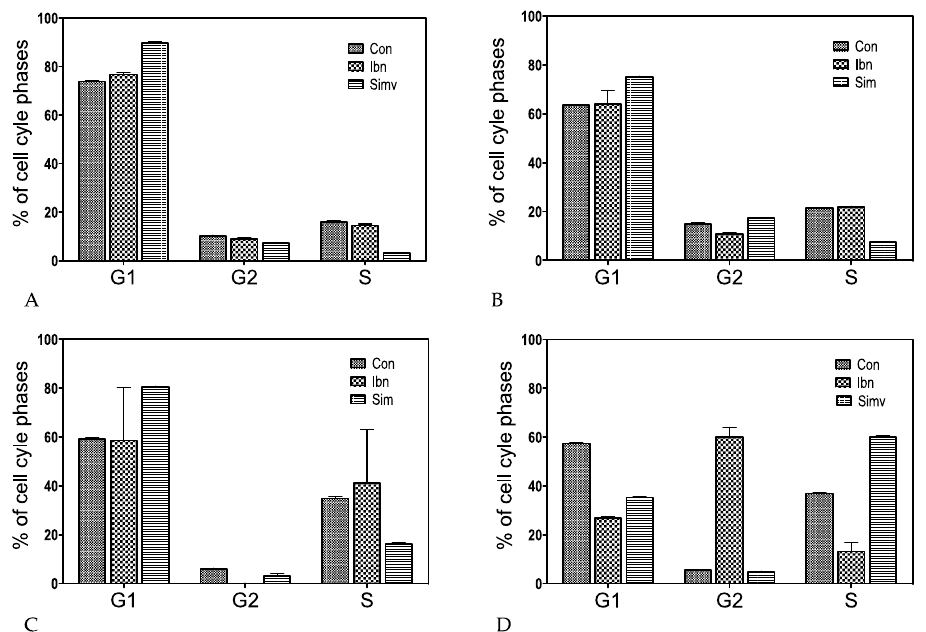
Figure 1. The distribution of cell cycle phases was analyzed by flow cytometry in PC-3 prostate cancer ( A ); MDA-MB-231 breast cancer ( B ); U-2 osteosarcoma ( C ) and MG-63 osteoblast-like ( D ) cells. Table 2. Fold downregulation of cyclin A2 ( CCNA2 ).